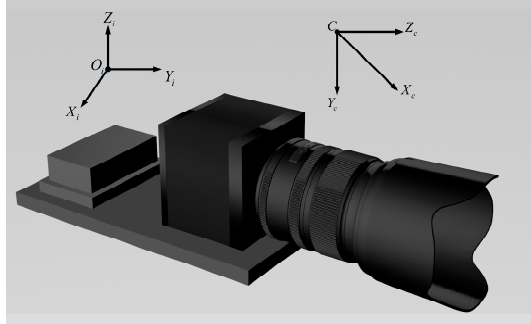
Figure 6. A photoelectric measurement system (System 1) with a high-resolution industrial camera and a dual-axis inclinometer.